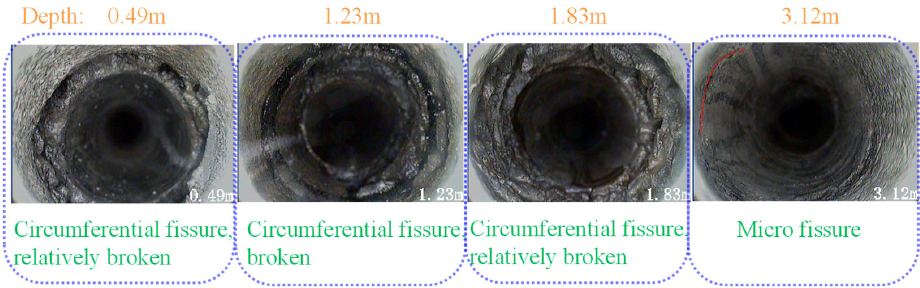
Figure 3. Distribution of roof separation fractures in ARR